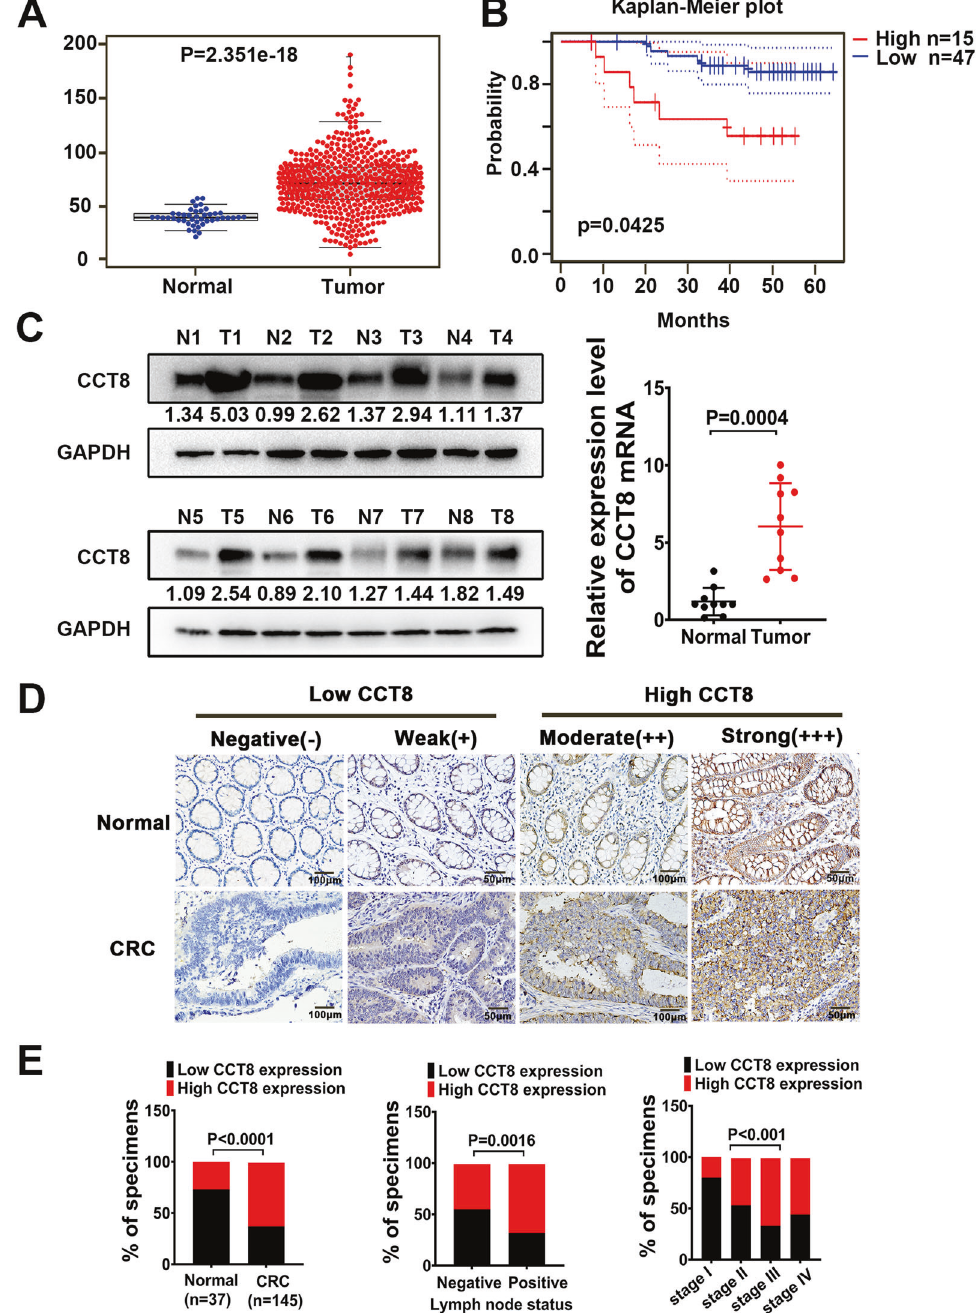
Fig. 6 High expression of CCT8 prompts the progression and poor prognosis of colorectal cancer. A CCT8 gene expression from TCGA CRC database. ( p = 2.351e-18). B Kaplan-Meier survival curves and univariate analyses(log-rank) of CRC samples obtained from PrognoScan database with distinct expression level of CCT8.( p = 0.0425). C Western Blot analysis was performed to detect CCT8 protein expression in CRC tissues (T) and adjacent non-tumor tissues (N). RT-PCR was performed to detect the CCT8 mRNA expression in CRC tissues and adjacent non- tumor tissues. D The expression of CCT8 in CRC tissues and adjacent nontumor tissues. E Graphical illustration of statistical CCT8 distribution in CRC tissues. CCT8 was signi fi cantly higher in CRC than in adjacent nontumorous tissue. The high expression of CCT8 was more frequently found in CRC with lymph node metastasis than in CRC without lymph node metastasis (N0). The high expression of CCT8 was more frequently found in advanced CRC (Stage I < Stage II < Stage cycle-related molecules (CDK4, CDK6, cyclinD1, myc), and promote in tumor cell cycle regulation related to cell proliferation and cancer tumor cell proliferation. In p53 mutant colorectal cancer cell line progression. In this study, the results of nuclear cytoplasmic protein HCT15, CCT8 did not affect cell cycle progression. and cell cycle assay con fi rmed that in p53 wild type colorectal cancer It has been reported that p53 also plays a key role in EMT and cell line, CCT8 inhibited p53 entry into the nucleus, down-regulated metastasis [43]. P53 signal affects EMT transcription factors snail, cell cycle inhibitory proteins p21 and P27, and up-regulated cell